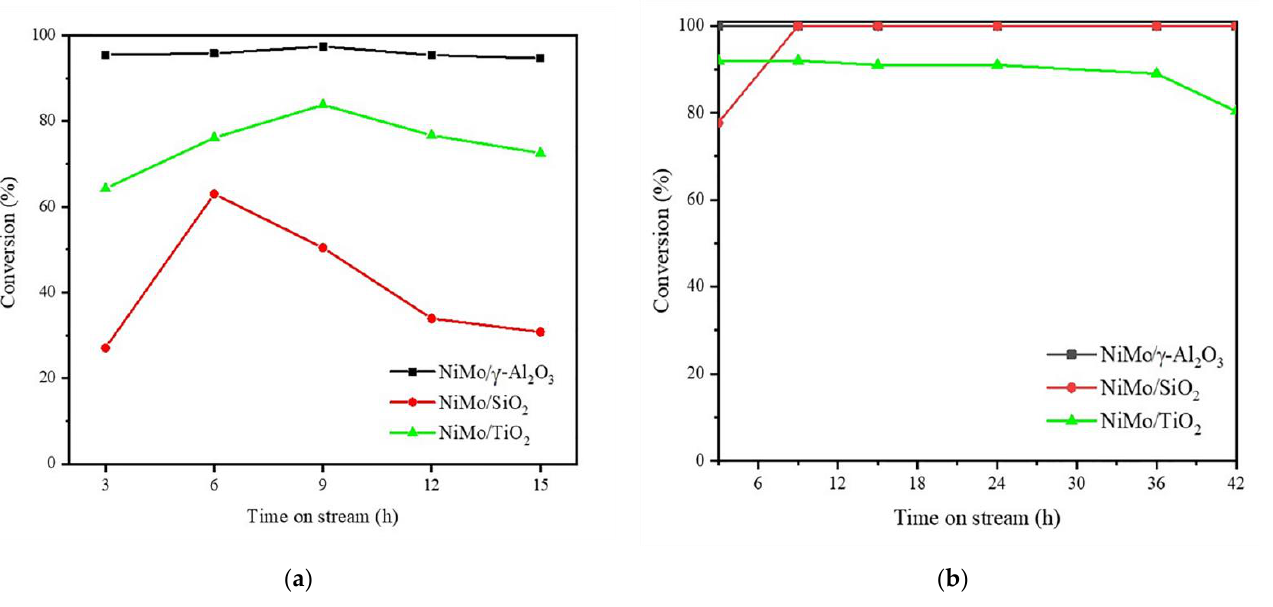
Figure 10. Effect of reaction time on conversion of ( a ) Pongamia Pinnata oil and ( b ) refined palm olein, over the various supported NiMoS. The experiment was conducted at a temperature of 330 °C, H 2 pressure of 50 bar, WHSV of 1.5 h −1 , and H 2 /oil ratio of 1000 cm 3 /cm 3 . Table 6. The impurities in the feedstocks.